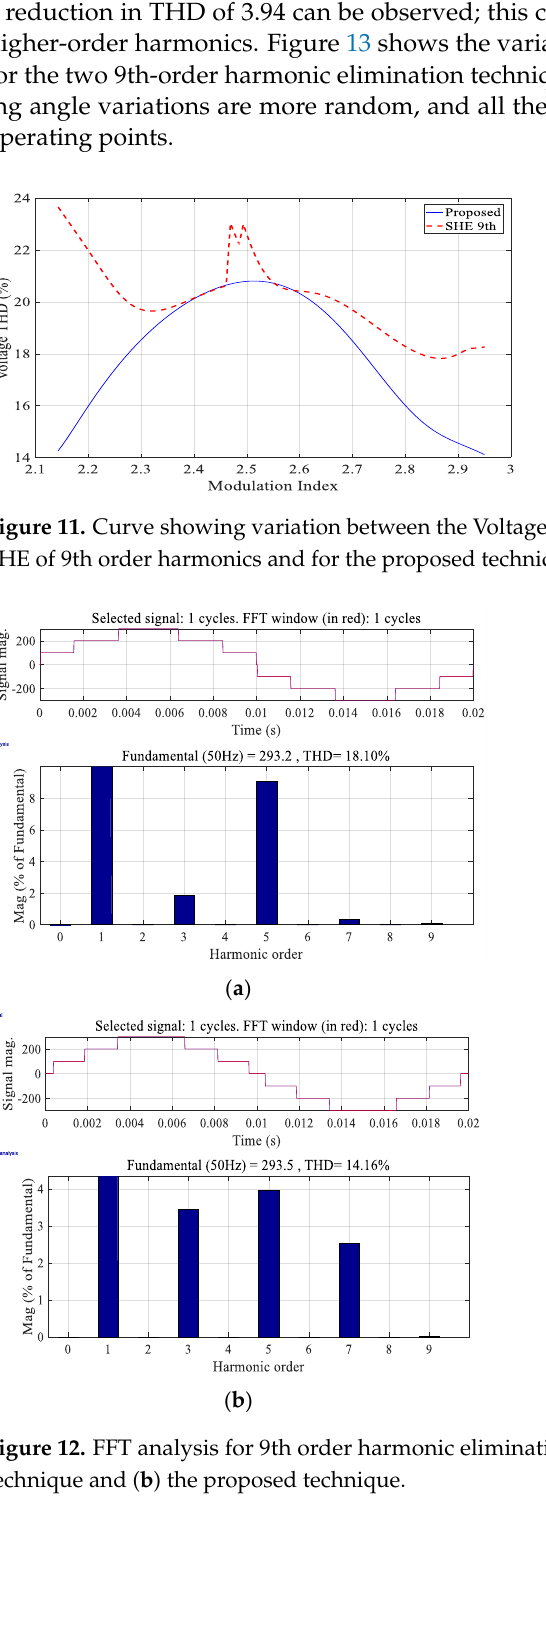
Figure 13. Curve showing variation between the estimated switching angles and modulation index for SHE of 9th-order harmonics and the proposed technique. 4. Simulation Results Simulations were performed for verification of the analysis. Harmonic analysis of the output voltage was performed employing the MATLAB fast Fourier transform (FFT) tool for the various techniques presented. Four modulation indexes were selected for analysis. A quasi-linear MLI was implemented, considering the aforementioned points. Figure 14 shows the output of the Quasi-linear MLI implemented with an inductively dominated RL Load. The values of the voltage THDs of output voltage were obtained by performing the MATLAB simulations and carrying out the FFT analysis on the inverter output.